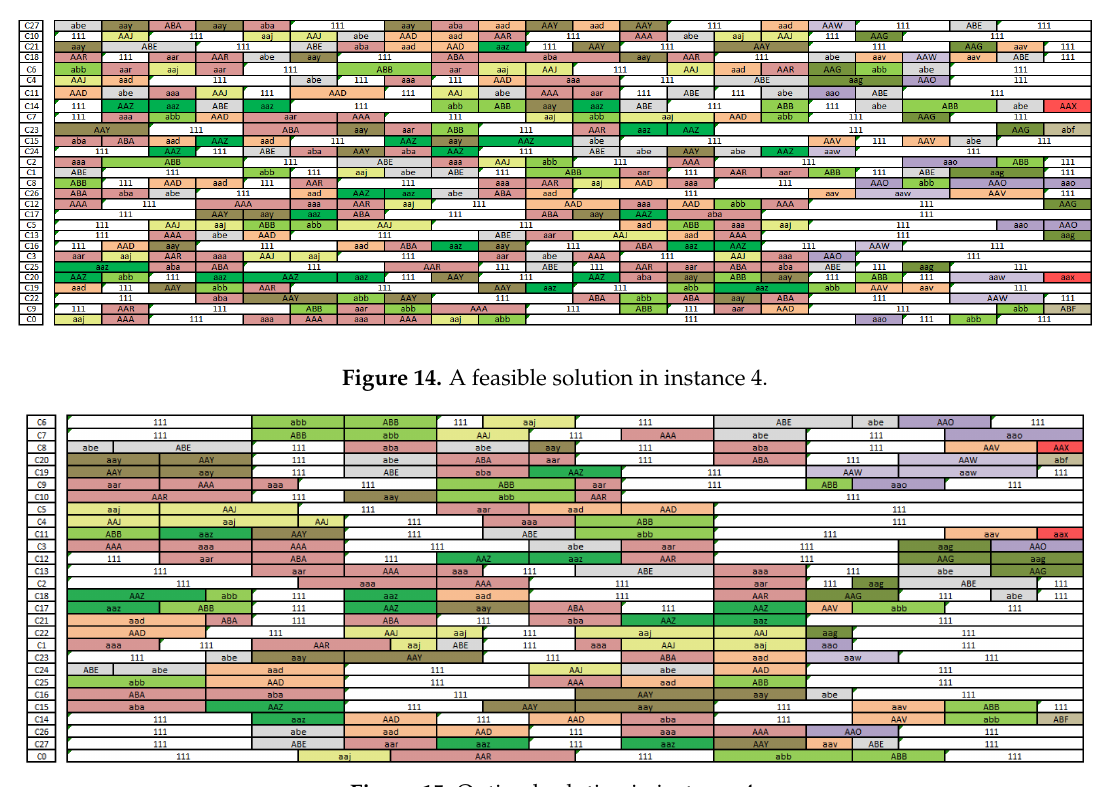
Figure 15. Optimal solution in instance 4.